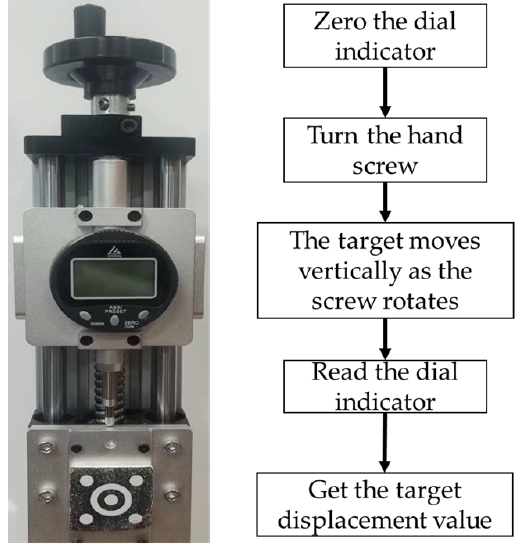
Figure 9. Step displacement measuring system.